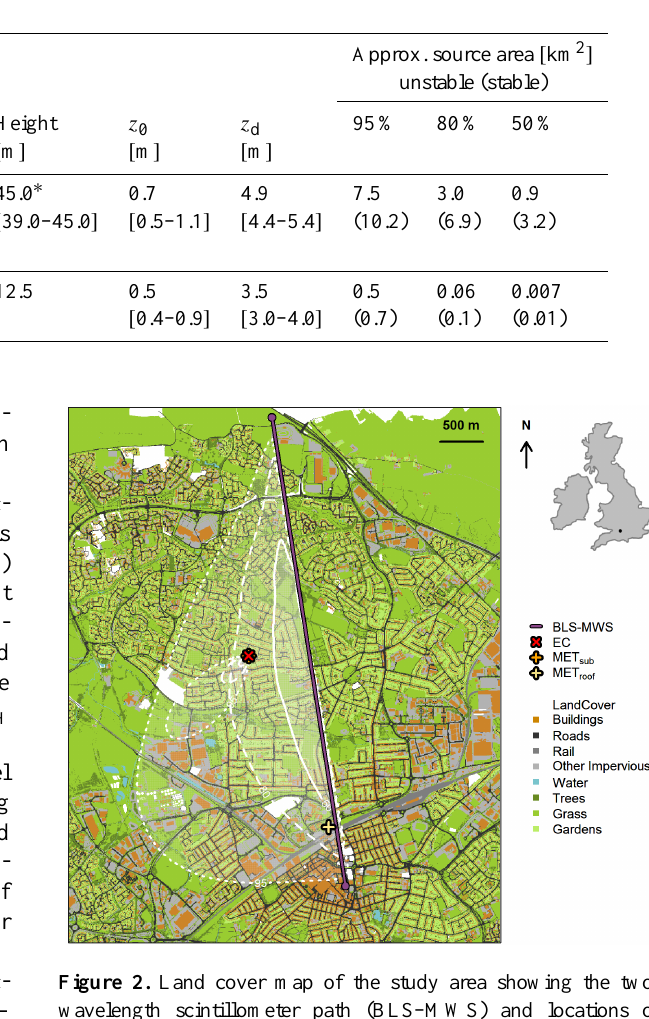
Table 1. Details of the scintillometer and eddy covariance systems. Tx denotes transmitter; Rx denotes receiver. ∗ The height of the scintil- lometer system is given as the effective height of the BLS. Values in square brackets represent the probable range of each quantity: the range in effective height represents the variation with stability; for z 0 and z d these are based on the literature (e.g. Grimmond and Oke, 1999). See text for details of the source area estimation.